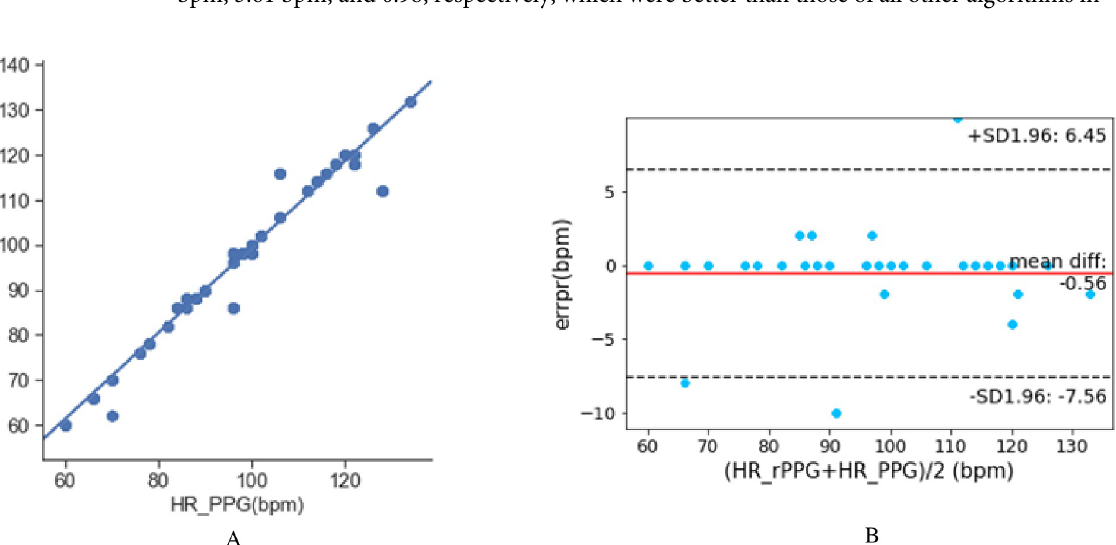
PLOS ONE | https://doi.org/10.1371/journal.pone.0275544 December30,